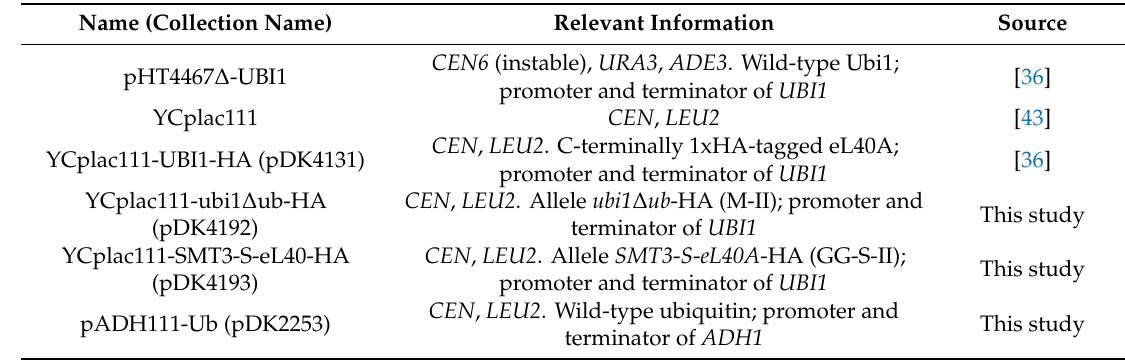
Table 2. Plasmids used in this